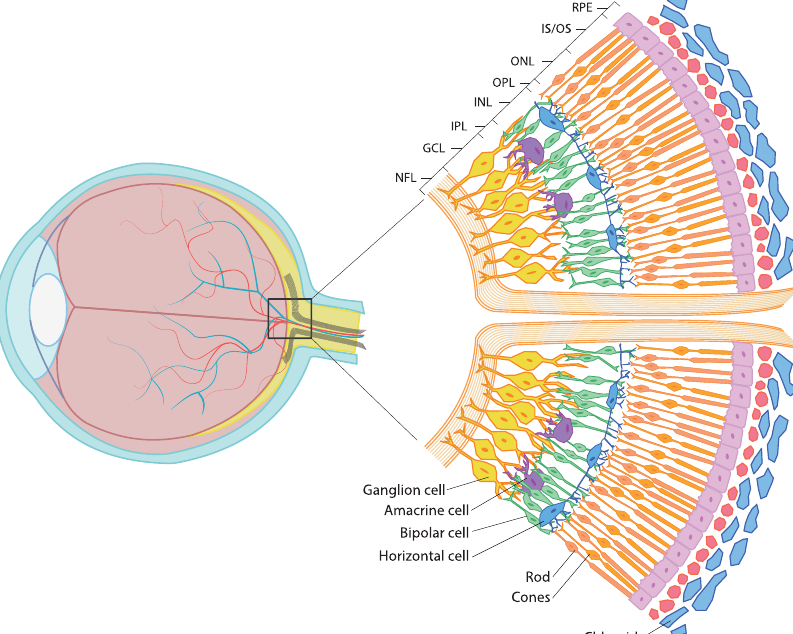
Fig. 1 Retinal layers. The composition of the individual layers of the retina in the area of the optic nerve. NFL nerve fi ber layer, GCL ganglion cell layer, IPL inner plexiform layer, INL inner nuclear layer, OPL outer plexiform layer, ONL outer nuclear layer, ELM external limiting membrane, IS/OS rod and cone inner and outer segments, RPS retinal pigment epithelium. Redrawn from